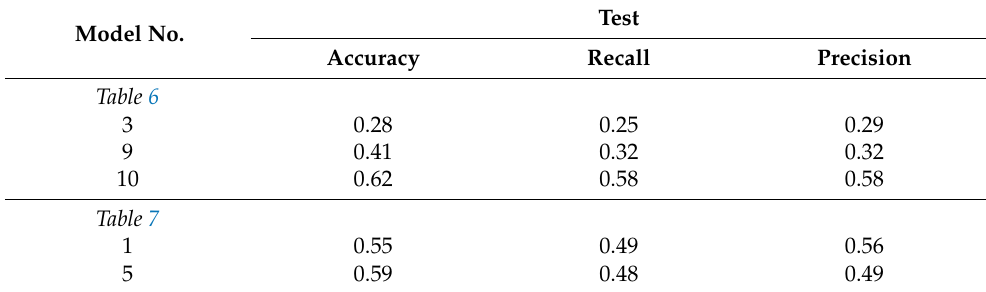
Table 8. Classification results on the test data set for the assignment of kidneys into three functional classes. Model